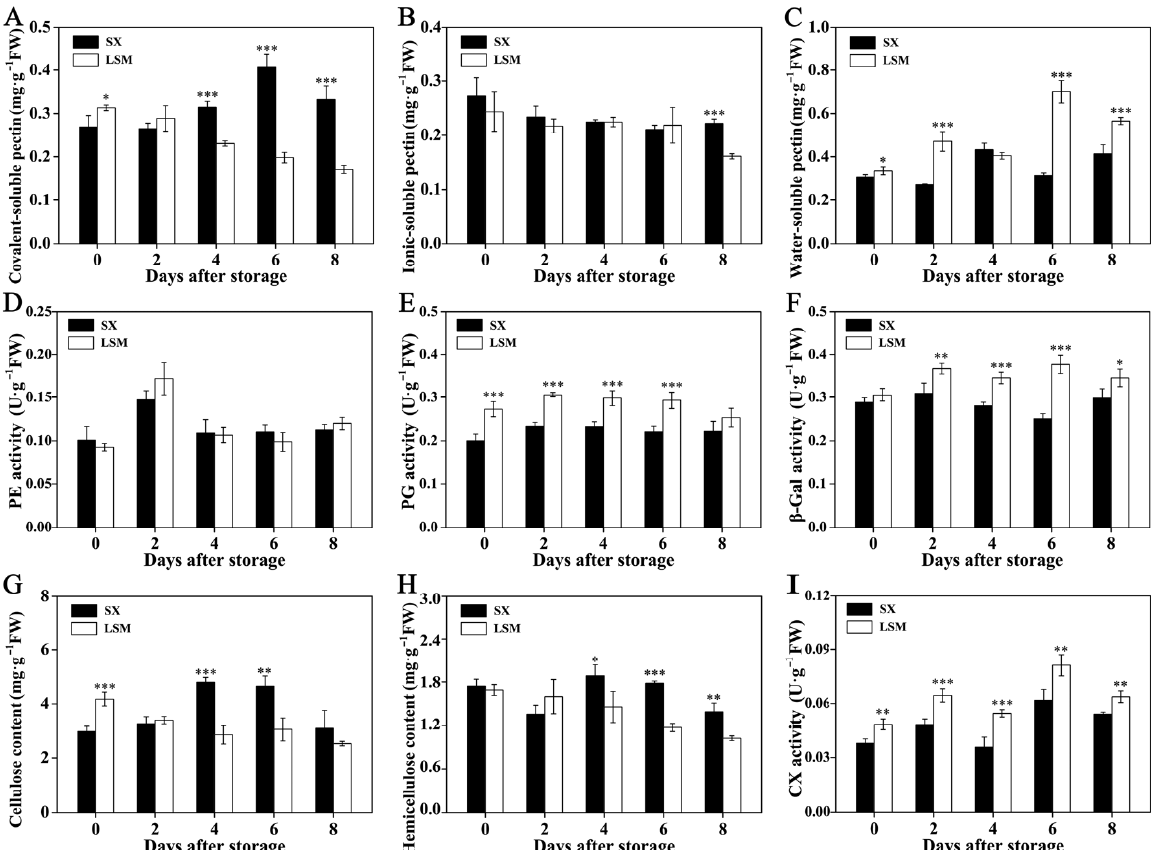
Figure 4. The contents of pectin and cellulose components and activities of the related enzymes of 'Shixia' and 'Luosanmu' longan aril during the room-temperature storage. ( A ) Covalent-soluble pectin content, ( B ) Ionic-soluble pectin content, ( C ) water-soluble pectin content, ( D ) PE activity, ( E ) PG activity, ( F ) β -Gal activity, ( G ) Cellulose content, ( H ) Hemicellulose con- tent, ( I ) CX activity. *: 0.01 < p < 0.05: **: 0.001 < p < 0.01; ***: p < 0.001. FW: fresh